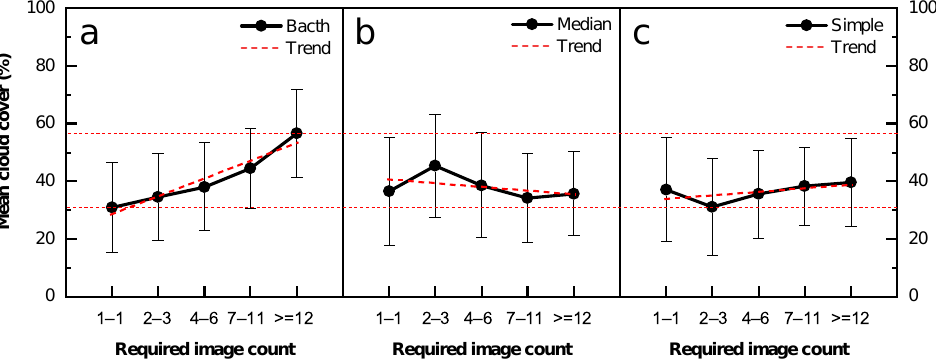
Figure 7. ( a – c ) Trend graph of the relationship between the required scenes count and cloud coverage in 2019. In the first 1–1 group, the cloud coverage of the images used by the batch method is the lowest. Comparatively, only the batch trend shows a considerable increase in the